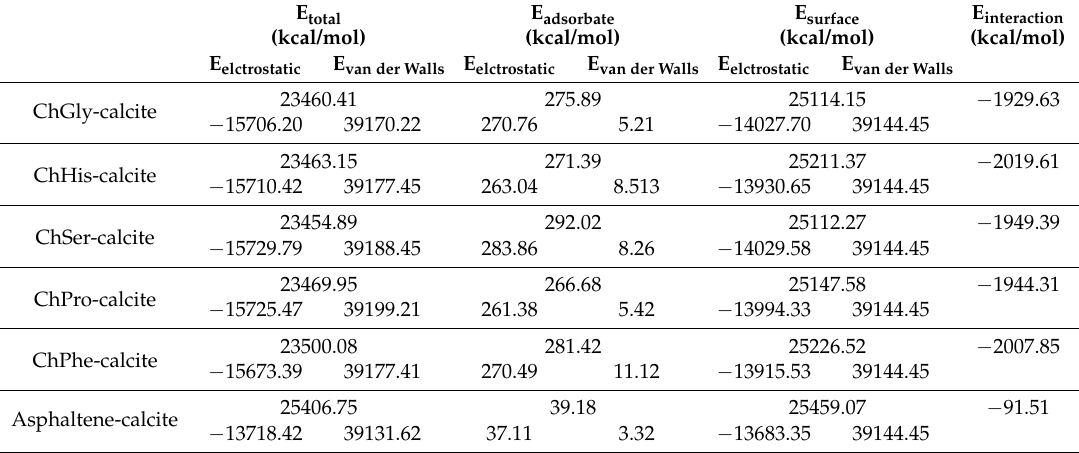
Table 6. Interaction energy calculation of AAILs-carbonate interfaces.